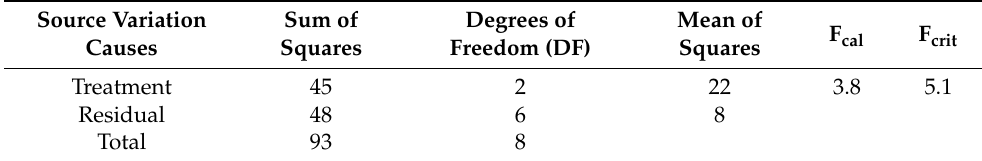
Table 3. Analysis of variance (ANOVA) applied to the BFS results of MASs with second layer of 30 vol% guaruman fibers epoxy composites, comparing distinct fibers configurations. Source Variation Sum of Degrees of Mean of F cal F crit Causes Squares Freedom (DF) Squares Treatment 45 2 22 3.8 5.1 Residual 48 6 8 Total 93